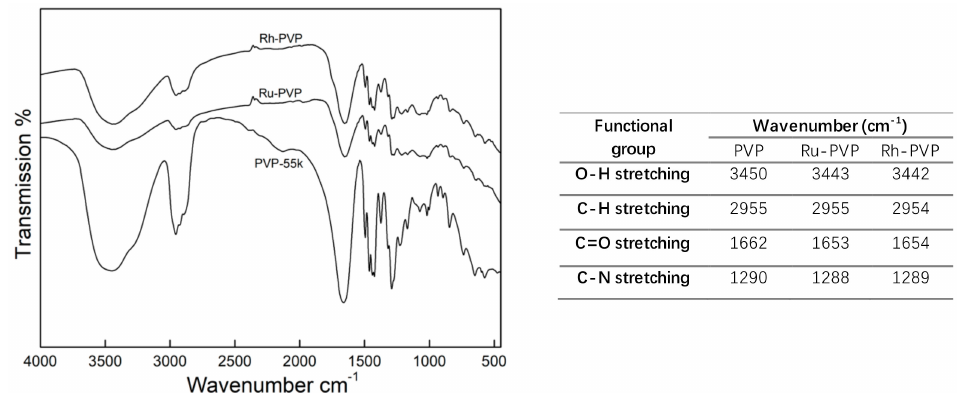
Figure 2. Fourier-transform infrared spectra (FT-IR), and assignment of observed bands to the functional groups, for pure PVP (55 kDa) and as-synthesized, PVP-coated Ru-2 and Rh-2 NPs.